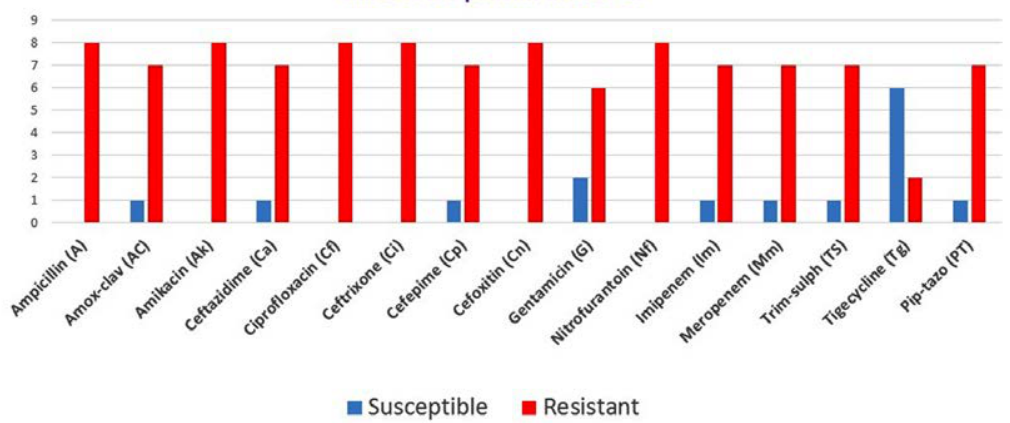
Fig. 7. Antimicrobial susceptibility trend of Acinetobacter baumannii complex cultured from urine of ICU patients